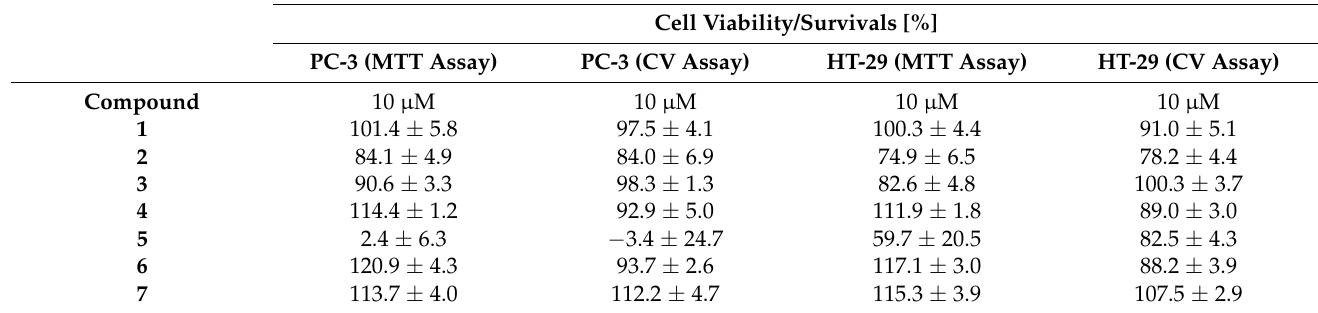
Table 4. Antiproliferative and cytotoxic activities of isolated compounds ( 1 – 7 ) from P. obtusifolia against human prostate (PC-3) and colorectal (HT-29) cancer cell lines. Metabolic cell Viability (MTT)/Cytotoxicity (CV)